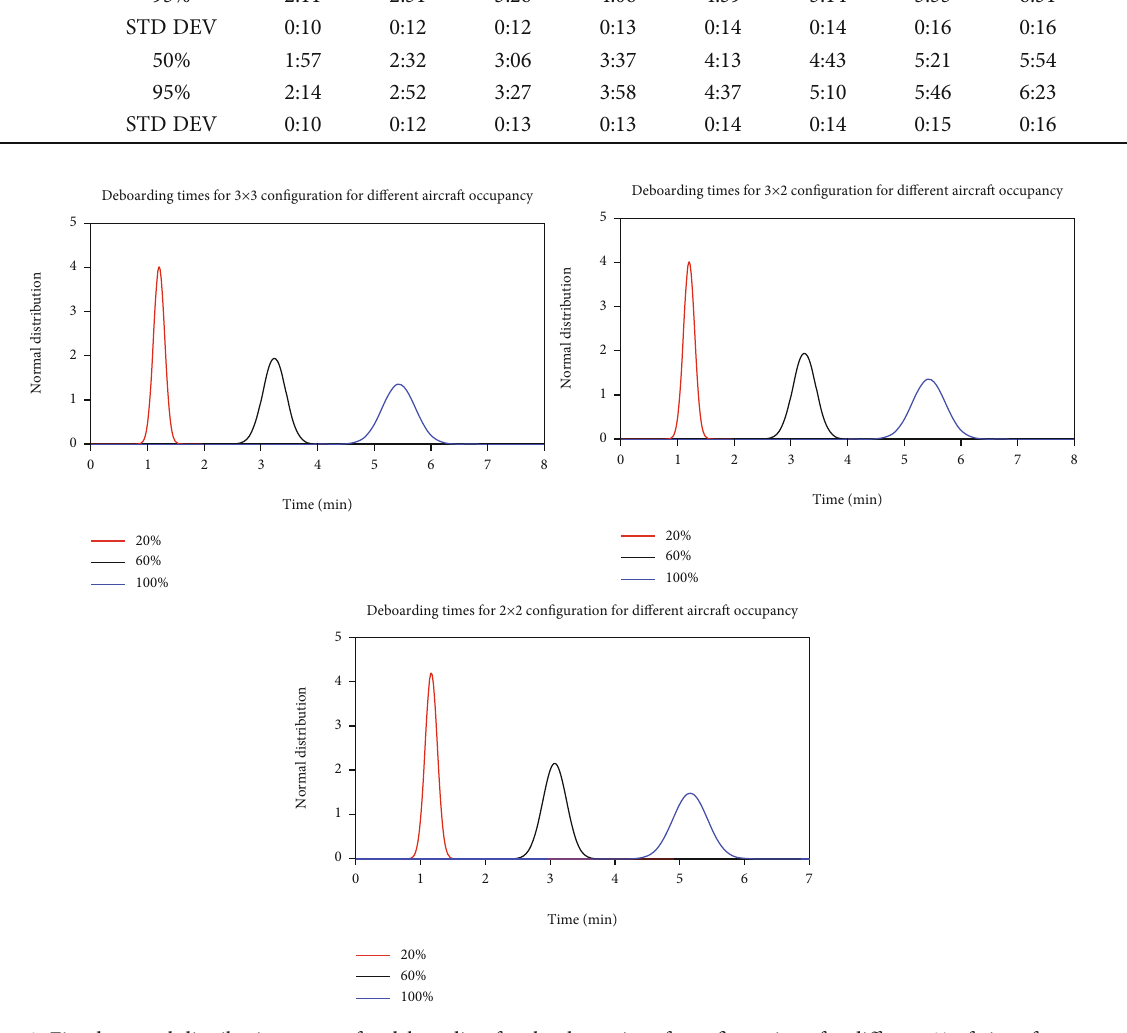
Figure 9: Fitted normal distribution curves for deboarding for the three aircraft con fi gurations for di ff erent % of aircraft occupancy.